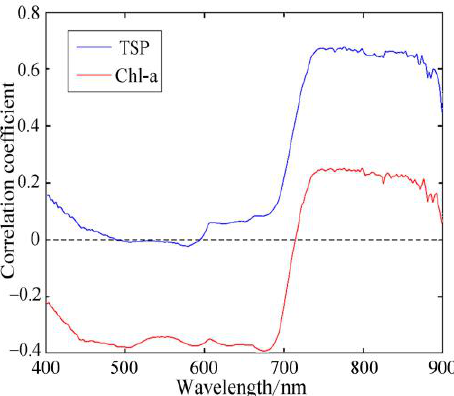
Figure 5. Correlation coefficient between remote sensing reflectance and TSP/Chl-a concentration.